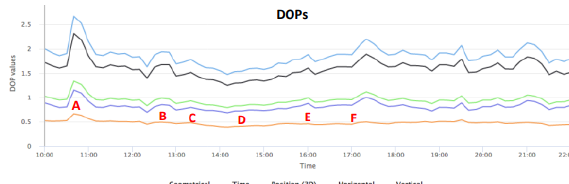
Figure 8 : Precision of each method at different sites